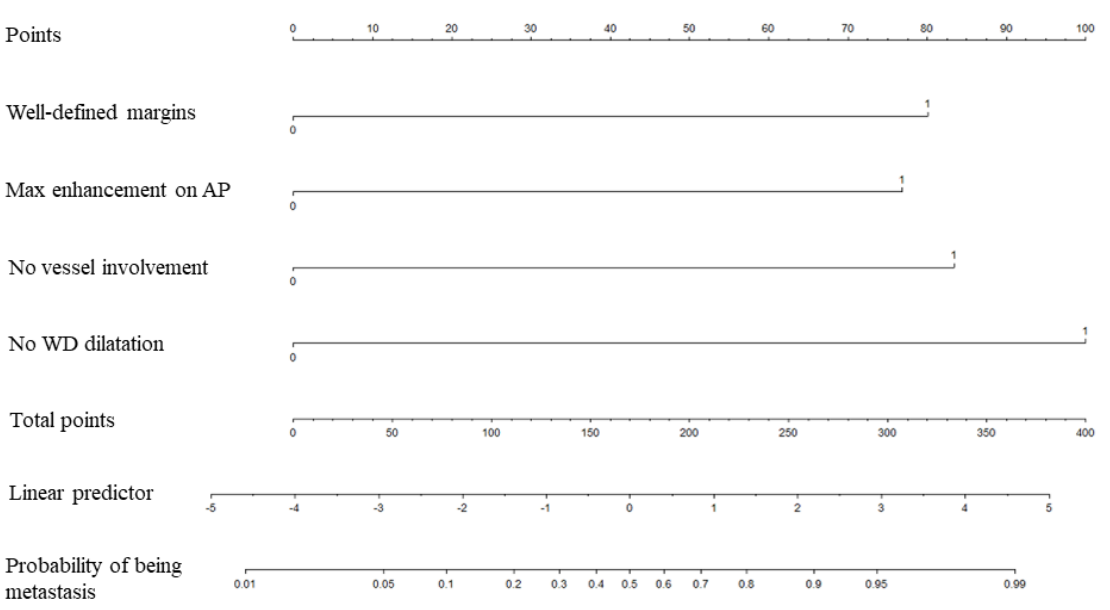
Figure 7. Nomogram for the diagnosis of pancreatic parenchyma metastases vs. pancreatic ductal adenocarcinoma using computed tomography (CT). The CT nomogram was developed using qualitative CT variables. AP indicates arterial phase. WD indicates Wirsung duct.